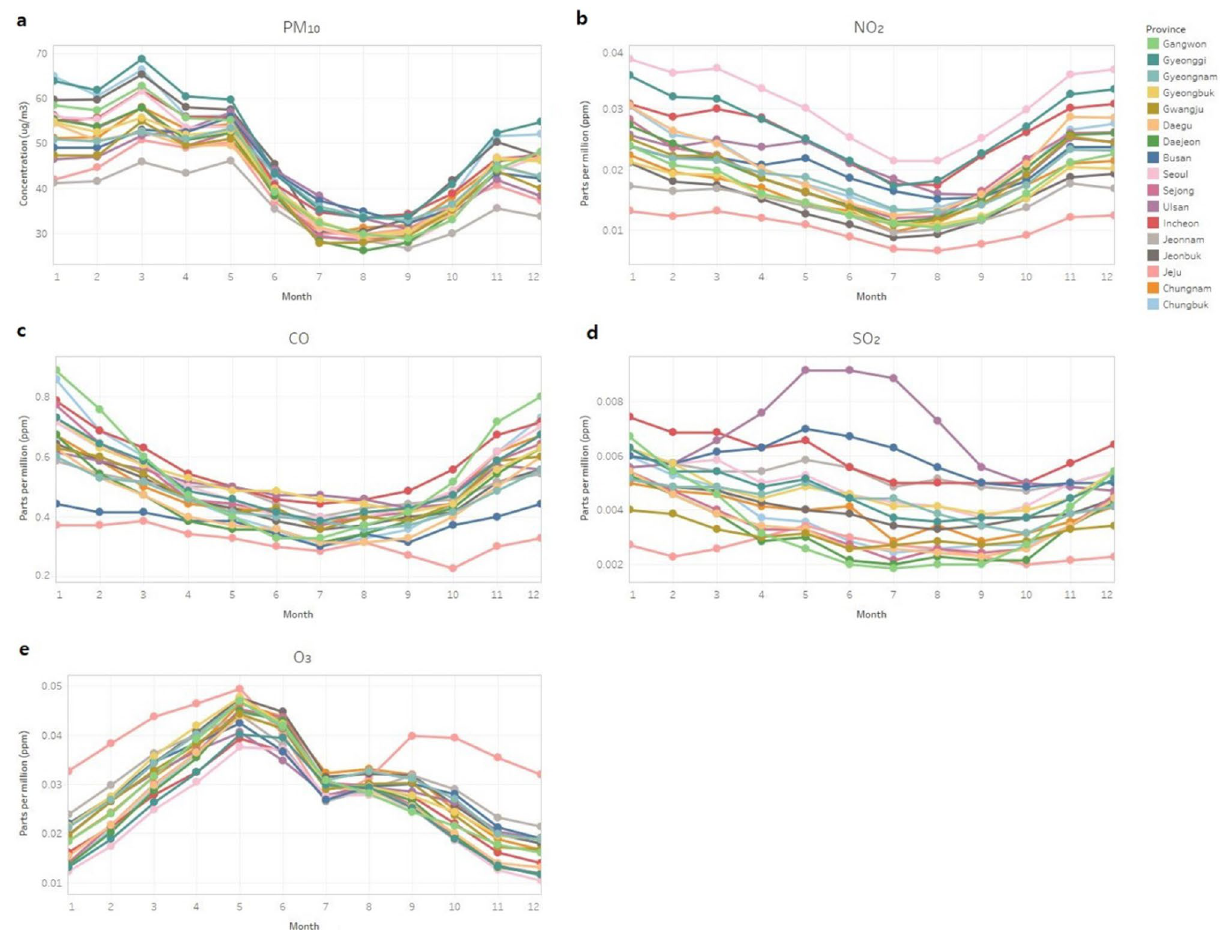
Figure 3. Air quality parameters by month in each region. ( a ) concentration of sulfur dioxide, ( b ) concentration of nitrogen dioxide, ( c ) concentration of carbon monoxide, ( d ) concentration of PM 10 , and ( e ) concentration of ozone.